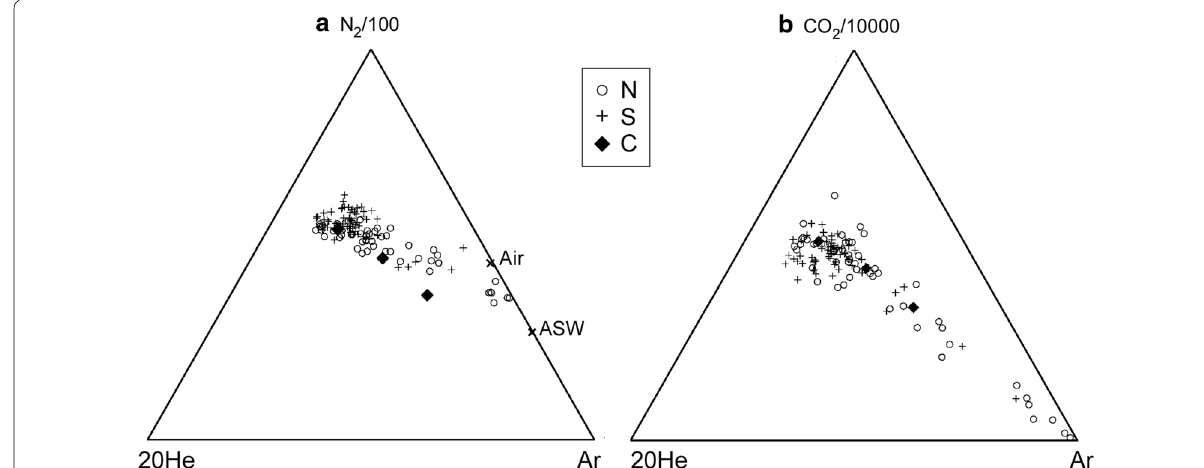
Fig. 5 Triangular diagrams for He–N 2 –Ar ( a ) and He–CO 2 –Ar ( b ) ternary systems